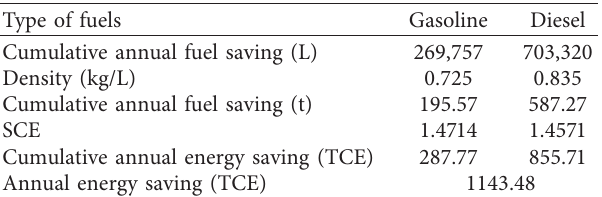
Table 9: Calculation of users’ energy-saving benefits from the Nanjing-Xuancheng highway reconstruction